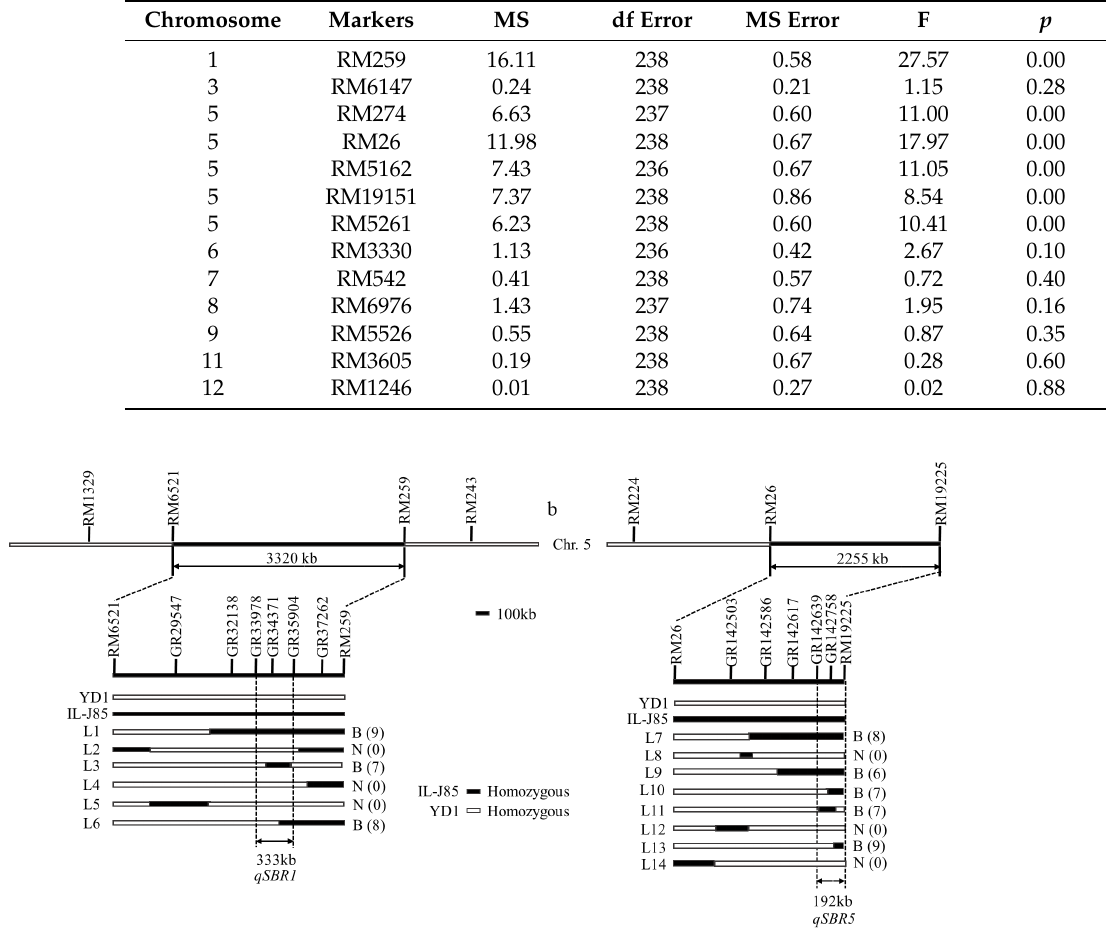
Figure 3. Fine mapping of the qSBR1 and qSBR5 locus. ( a ) qSBR1 was initially mapped to the interval between the markers RM6521 and RM259, and then narrowed to a 333 kb region between the markers GR33978 and GR35904. ( b ) qSBR5 was initially mapped to the interval between the markers RM26 and RM19225, and then narrowed to a 192 kb region between the markers GR142639 and RM19225. B: stem branch; N: no-stem branch; the number of individuals is in parentheses; L1–L6: